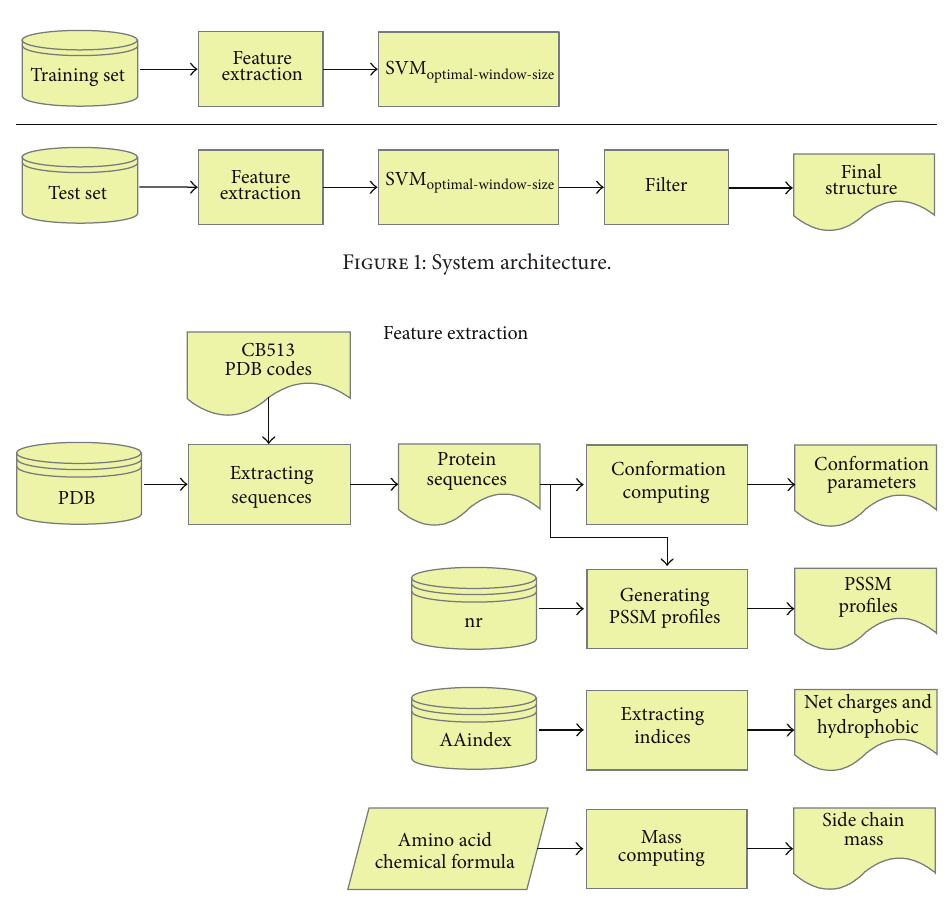
Figure 2: Process of feature